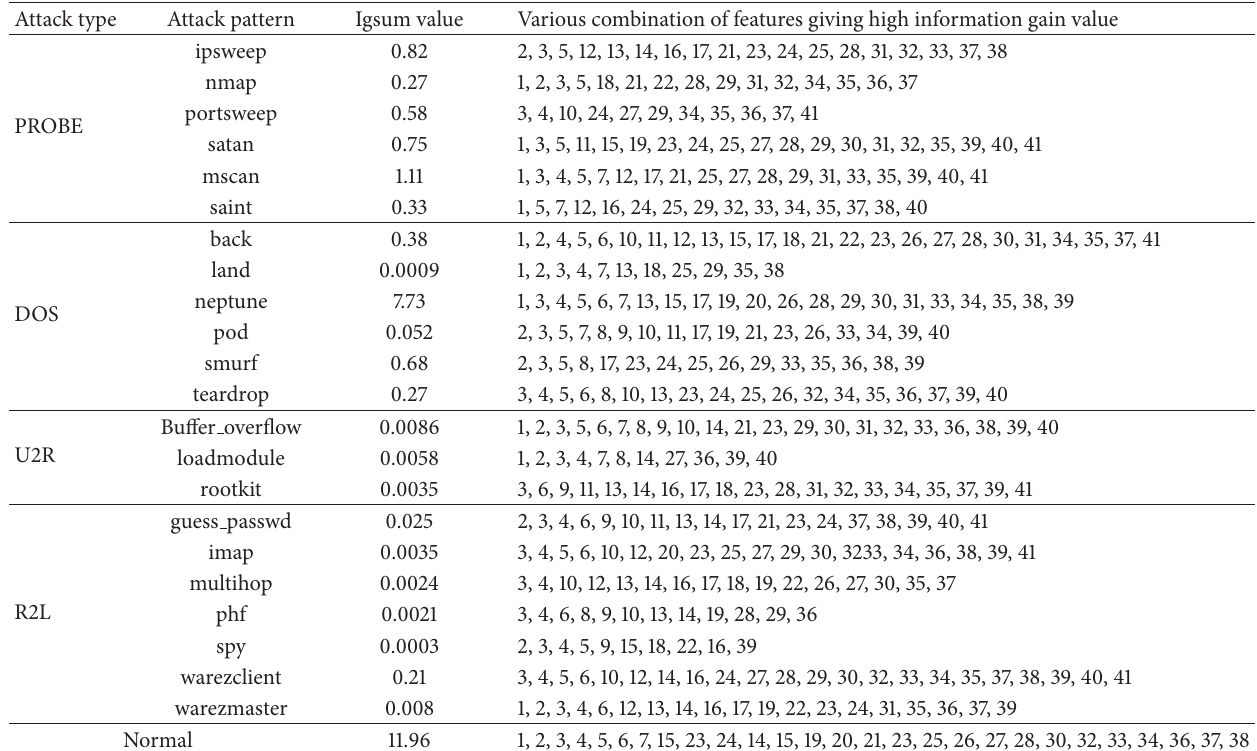
Table 2: Most relevant features for each attack and information gain measures.